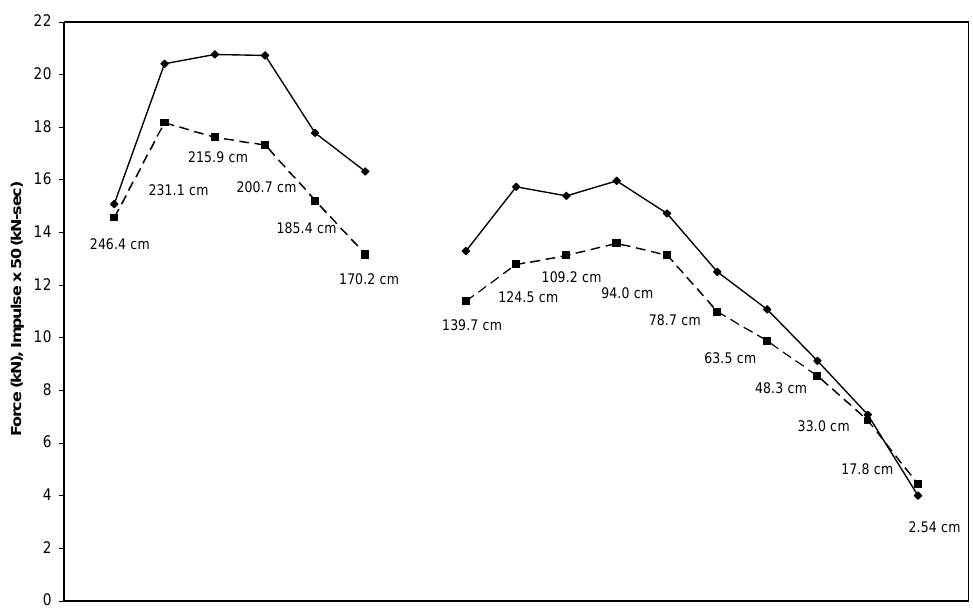
Fig. 9. Two sequences of dynamic tests on precycled Amsteel Blue rope with 0.95 cm diameter; weight = 289 N, decreasing